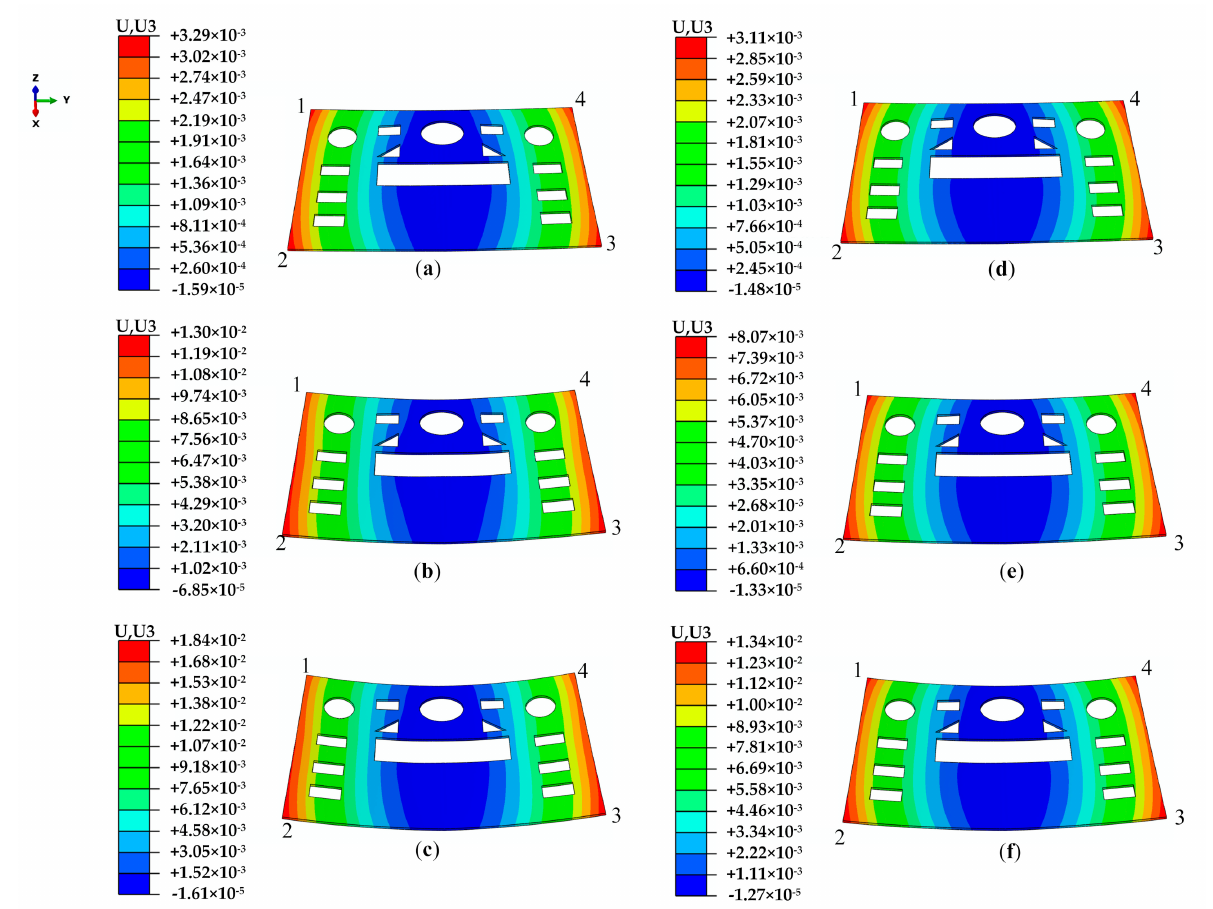
Figure 8. The total predicted warpage results of the parts (unit: m): ( a – c ) prediction with crystallinity; ( d – f ) prediction without crystallinity. ( a , d ) CIM; ( b , e ) RHCM60; ( c , f ) RHCM90.